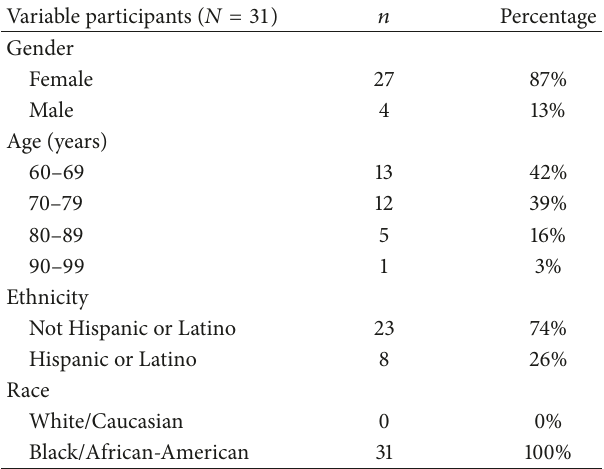
Table 1: Demographic characteristics of community dwelling older adults with